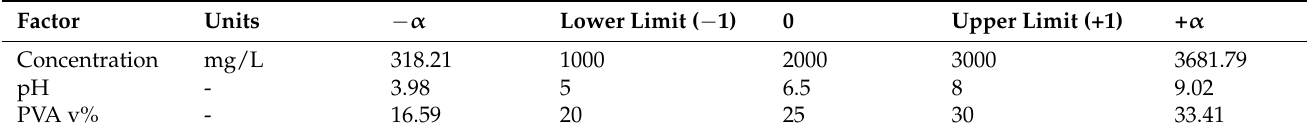
Table 3. Variables and levels applied for the removal of COD in GTL